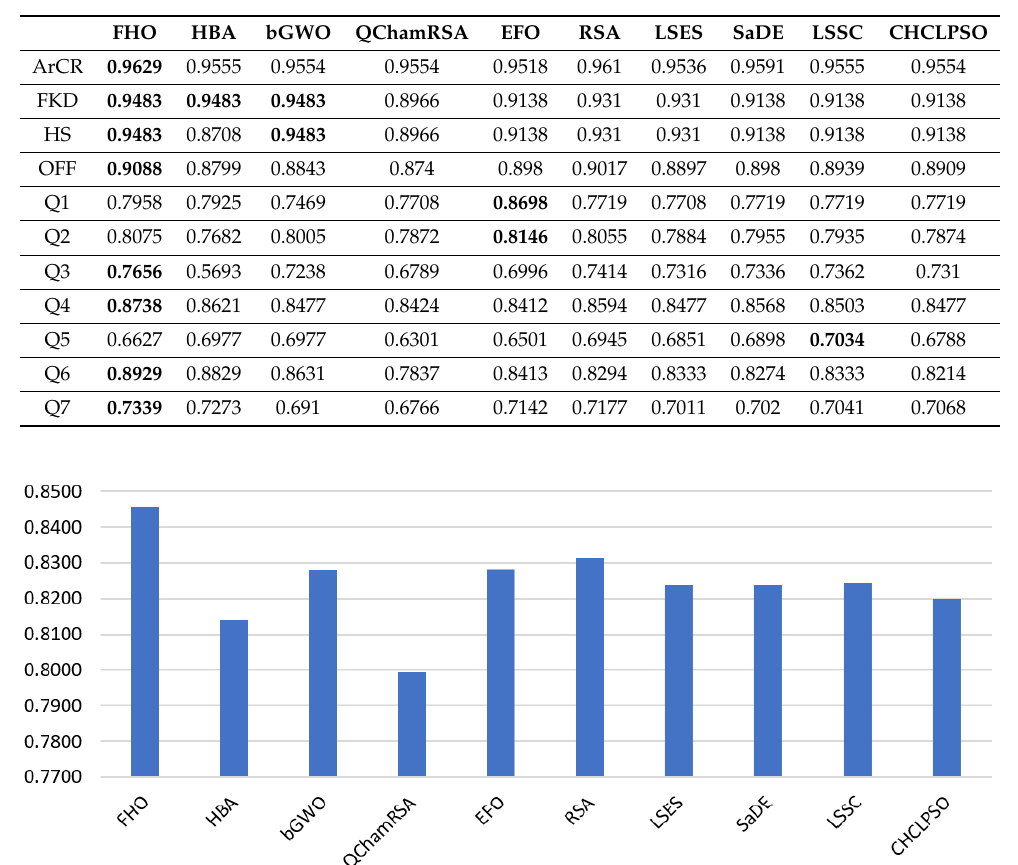
Table 6. Recall results obtained by FHO and other methods in the binary case.